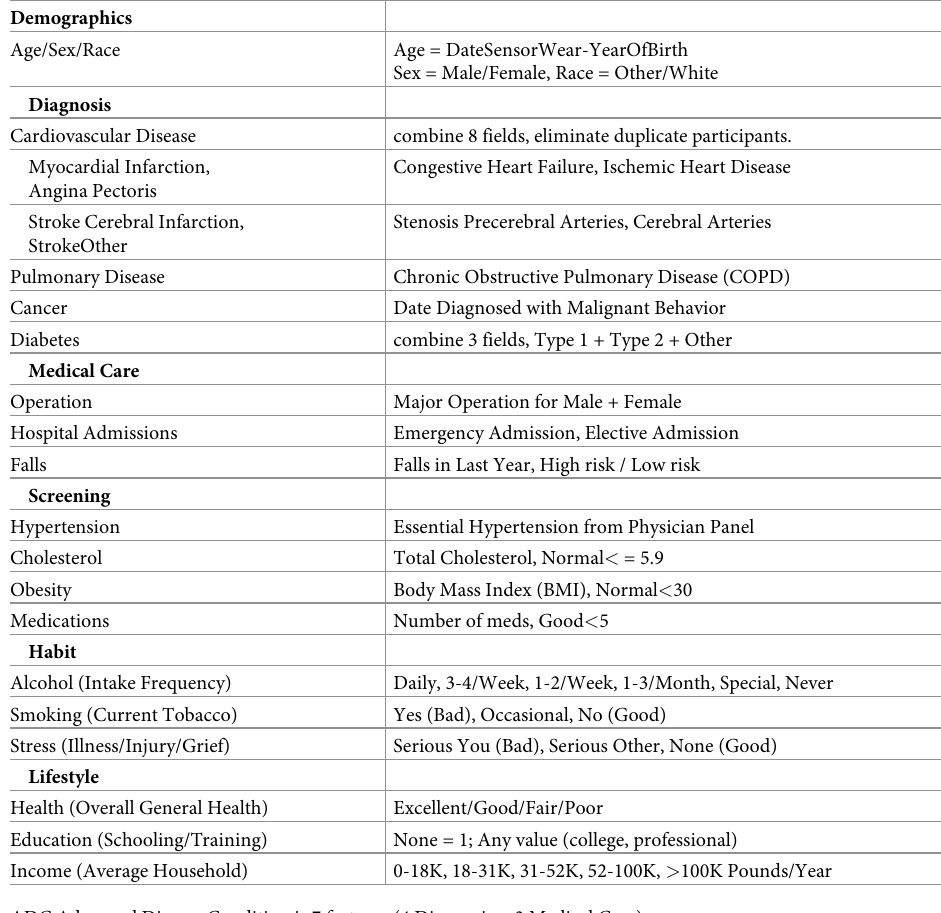
Table 1. Categorical Features from Question Answers in UK Biobank data